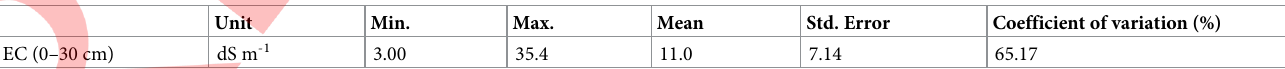
Table 5. Descriptive statistics of electrical conductivity (EC) values